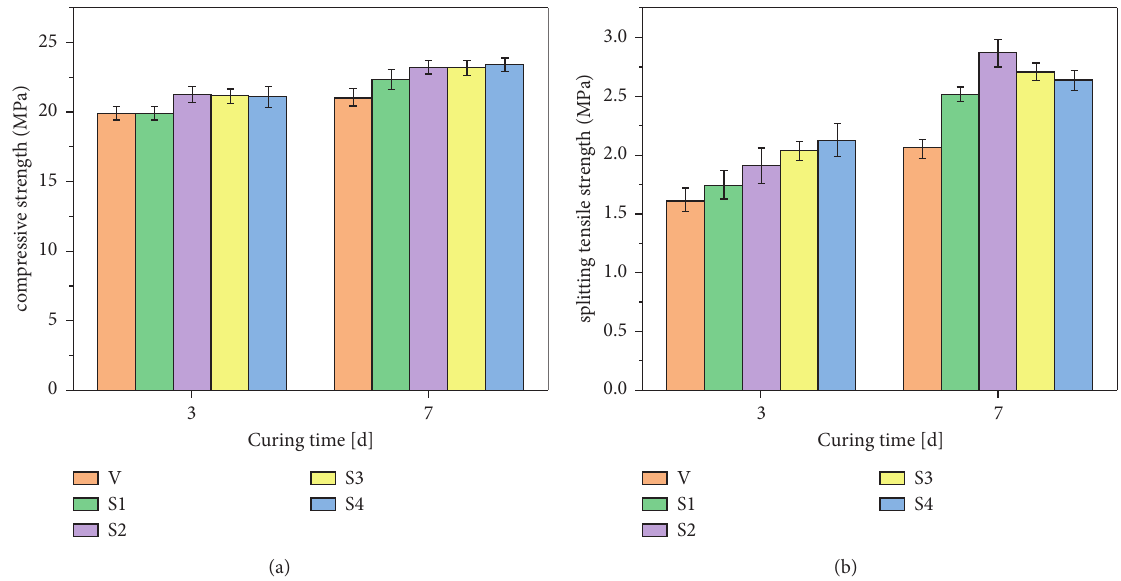
Figure 3: Influences of different curing times and different amounts of SiC whisker on the mechanical properties of slag. (a) Compressive strength. (b) Splitting tensile